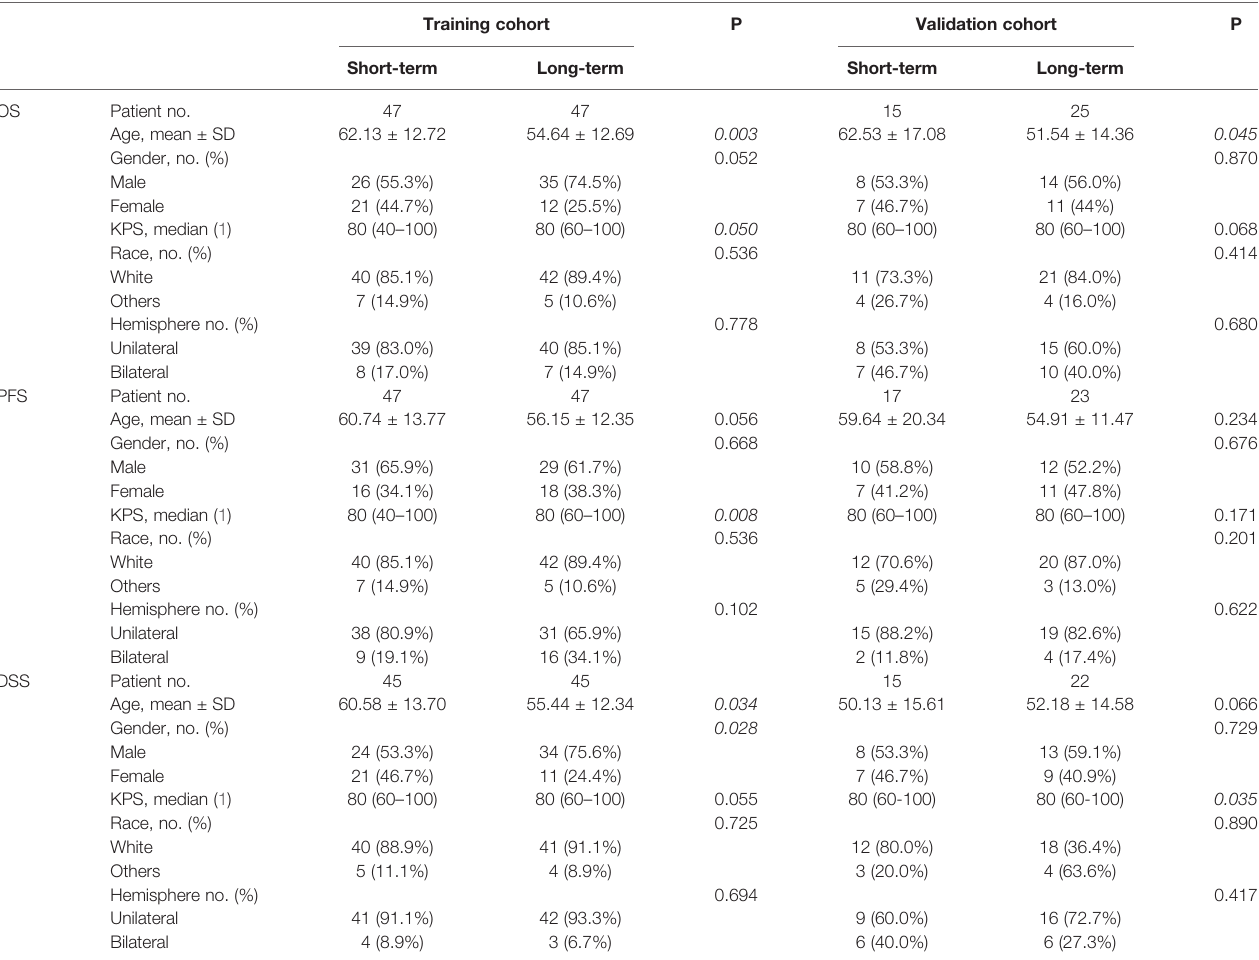
TABLE 1 | Characteristics of patients in the training and validation cohorts for OS, PFS, and DSS. Training cohort P Validation cohort